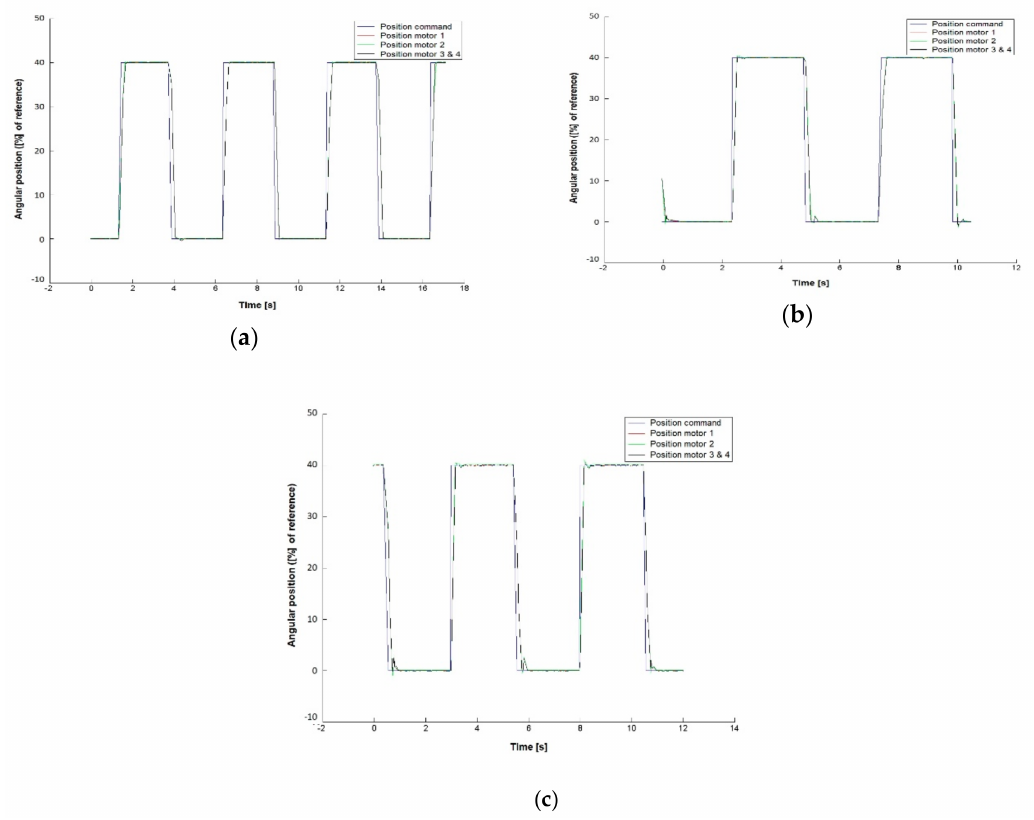
Figure A5. Result of di ff erent failure tests: ( a ) one sensor with bad information, ( b ) loss of one inverter leg, and ( c ) voltage supply of one motor is